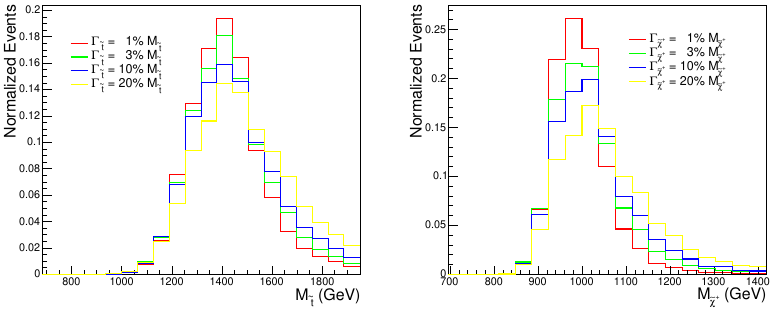
Figure 13 . The projected M ˜t (left) and M of the mass of both stop quark and chargino. The events have been generated for M ˜t = 1500 GeV, M = 1000 GeV and M ˜ ν = 800 x + 1